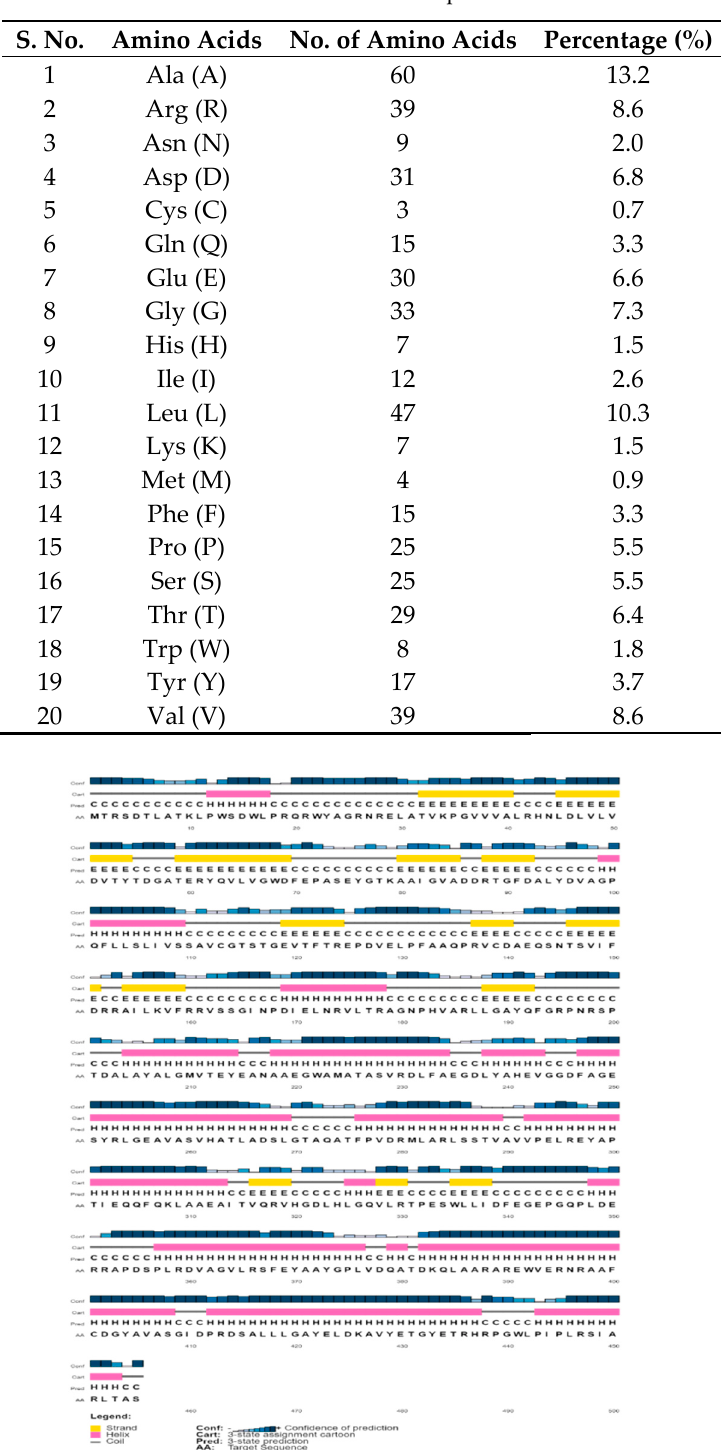
Table 3. Amino acid composition.